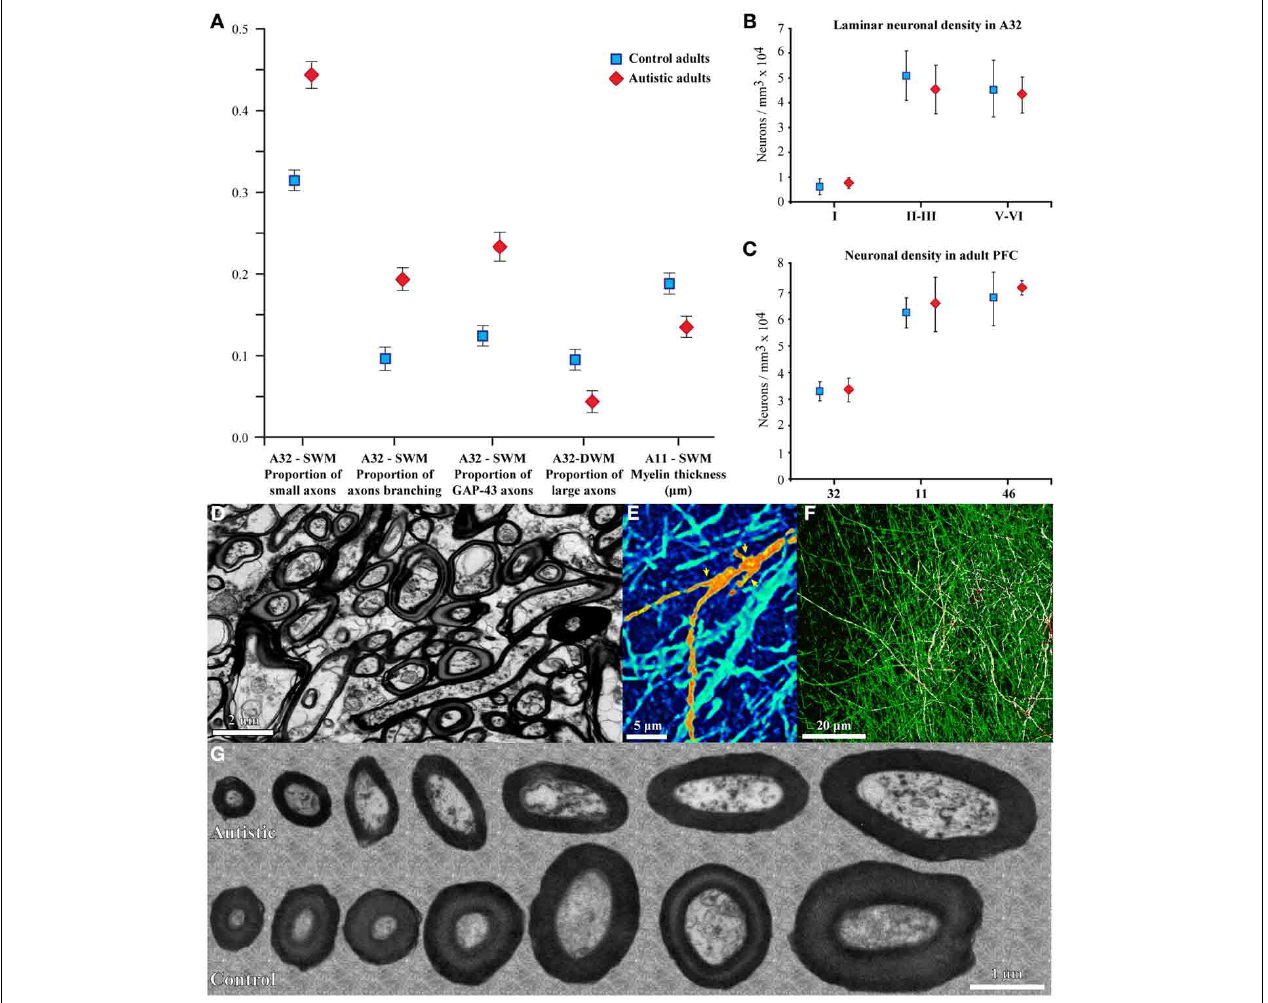
FIGURE 2 | Changes in myelinated axons below prefrontal cortices in adults with ASD. (A) In the superficial white matter (SWM) below ACC (area 32) the relative density of small (thin) axons ( ± SEM) is increased in the autistic cases, and more axons branch and express GAP-43. These data suggest increased local connectivity of ACC in ASD. In contrast, in the deep white matter (DWM) below ACC the relative density of large axons is reduced in ASD, suggesting weakening of long-range connectivity. Thinning of the myelin in axons of all sizes just below OFC (area 11) suggests weak local connections. (B,C) Laminar and overall neuronal density below ACC, OFC, and LPFC is similar in adults with ASD and controls and is not correlated with the changes in axons below PFC. (D) EM photomicrograph of